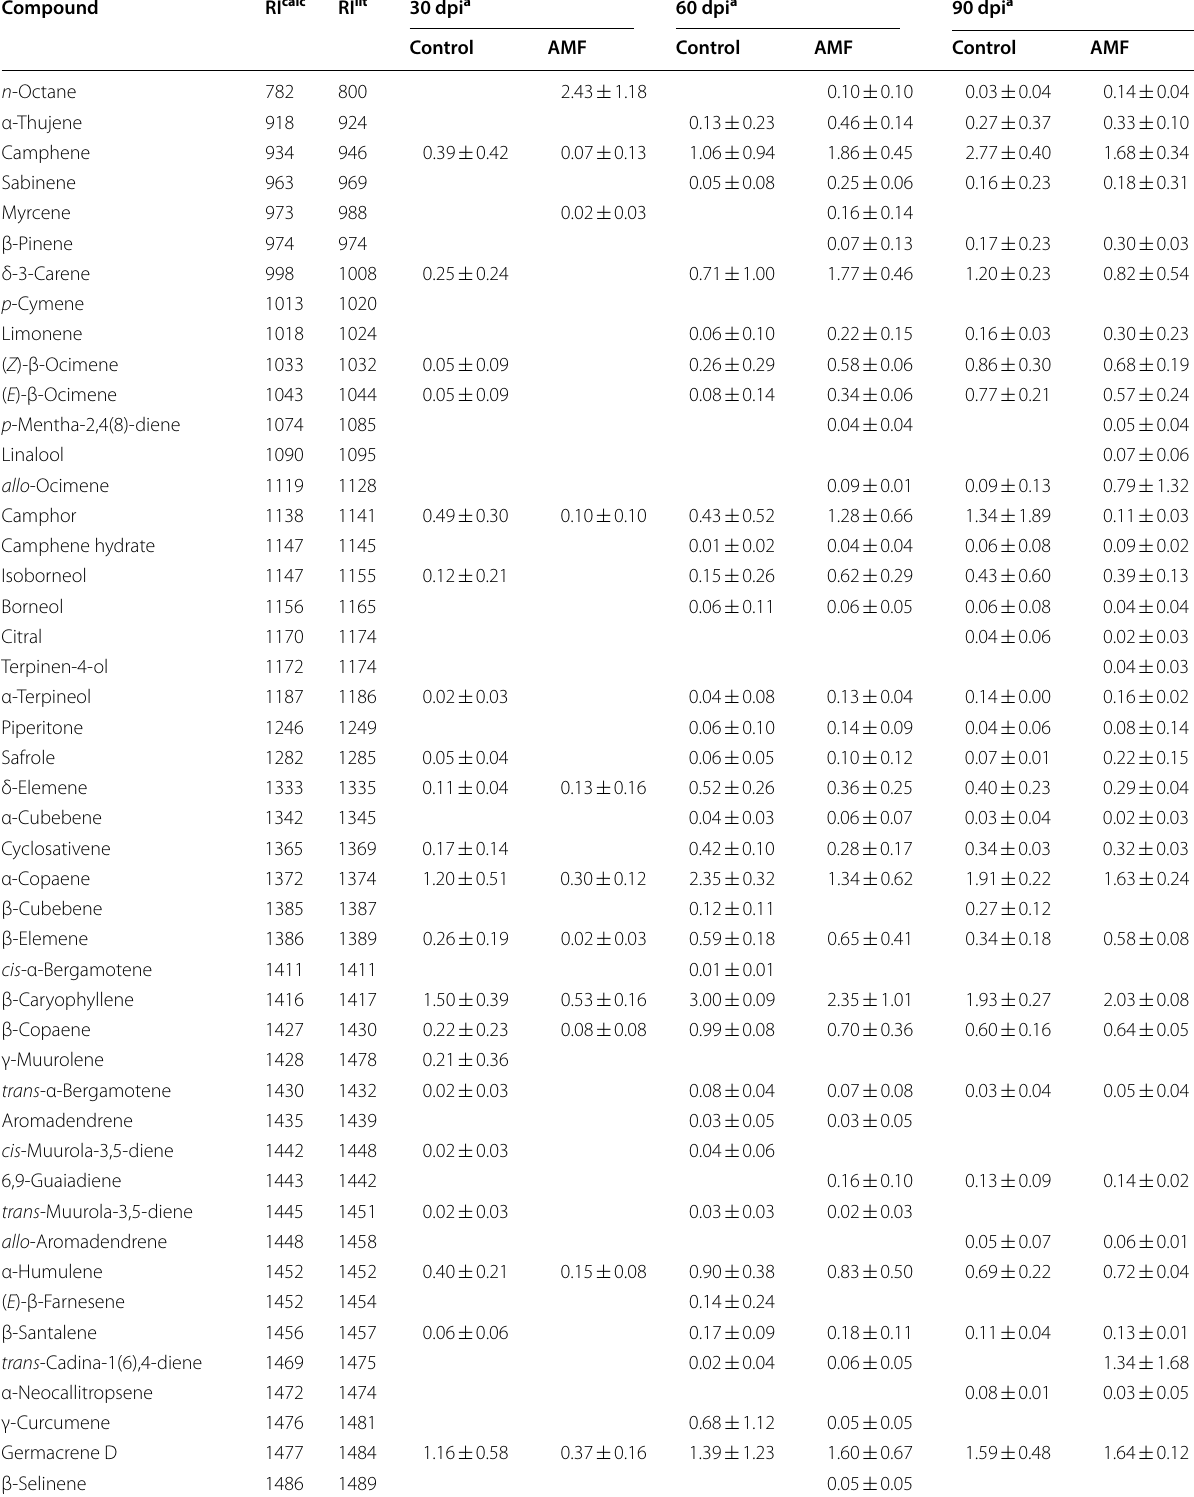
Table 3 Comparison of volatile components produced in inoculated and non-inoculated roots of P. aduncum (Mean standard